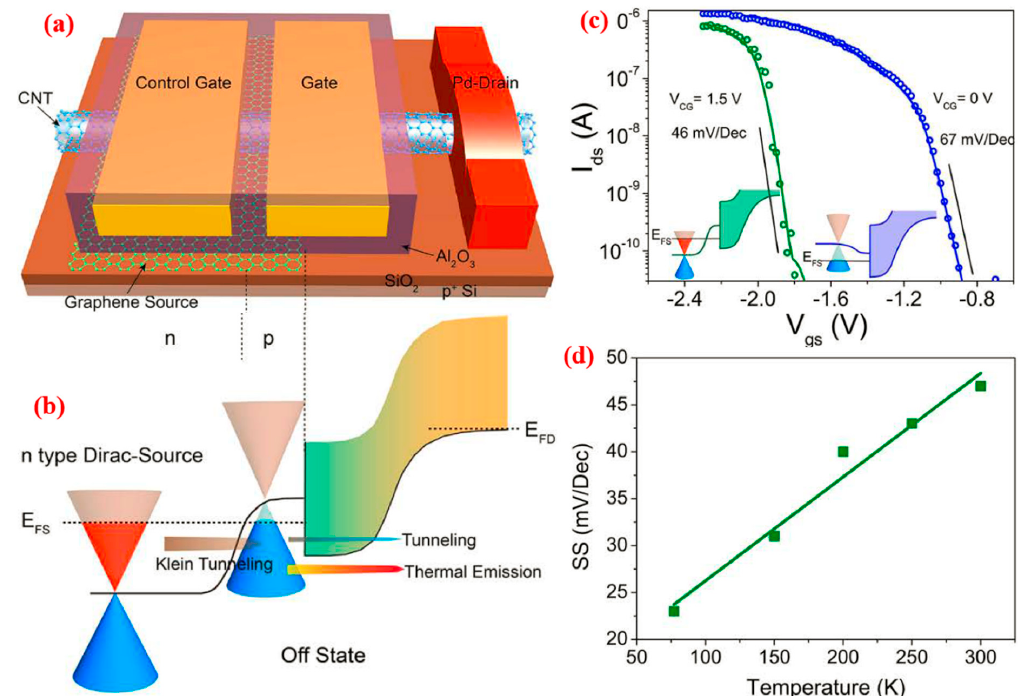
Figure 20. ( a ) Schematic diagram showing a Dirac-source field-effect transistor (DS-FET) with a control gate in addition to the normal gate. ( b ) Schematic diagrams illustrating the off-state of the DS-FET. ( c ) Transfer characteristics of a typical DS-FET at different V CG . Circles and lines represent experimental and simulated results, respectively. Green color represents results obtained at V CG = 1.5 V, and blue represents those obtained at V CG = 0 V. Inset figures are schematic band edge profiles for fitted data situations. ( d ) Temperature-dependent SS of a typical DS-FET measured at temperatures between 77 K and 300 K; V CG was set at 2 V to keep the device in Dirac-source mode. SS varied by more than 100% from 77 to 300 K. In all measurements, the substrate was biased with − 20 V to keep the ungated region near the drain open [158]. Copyright 2018,